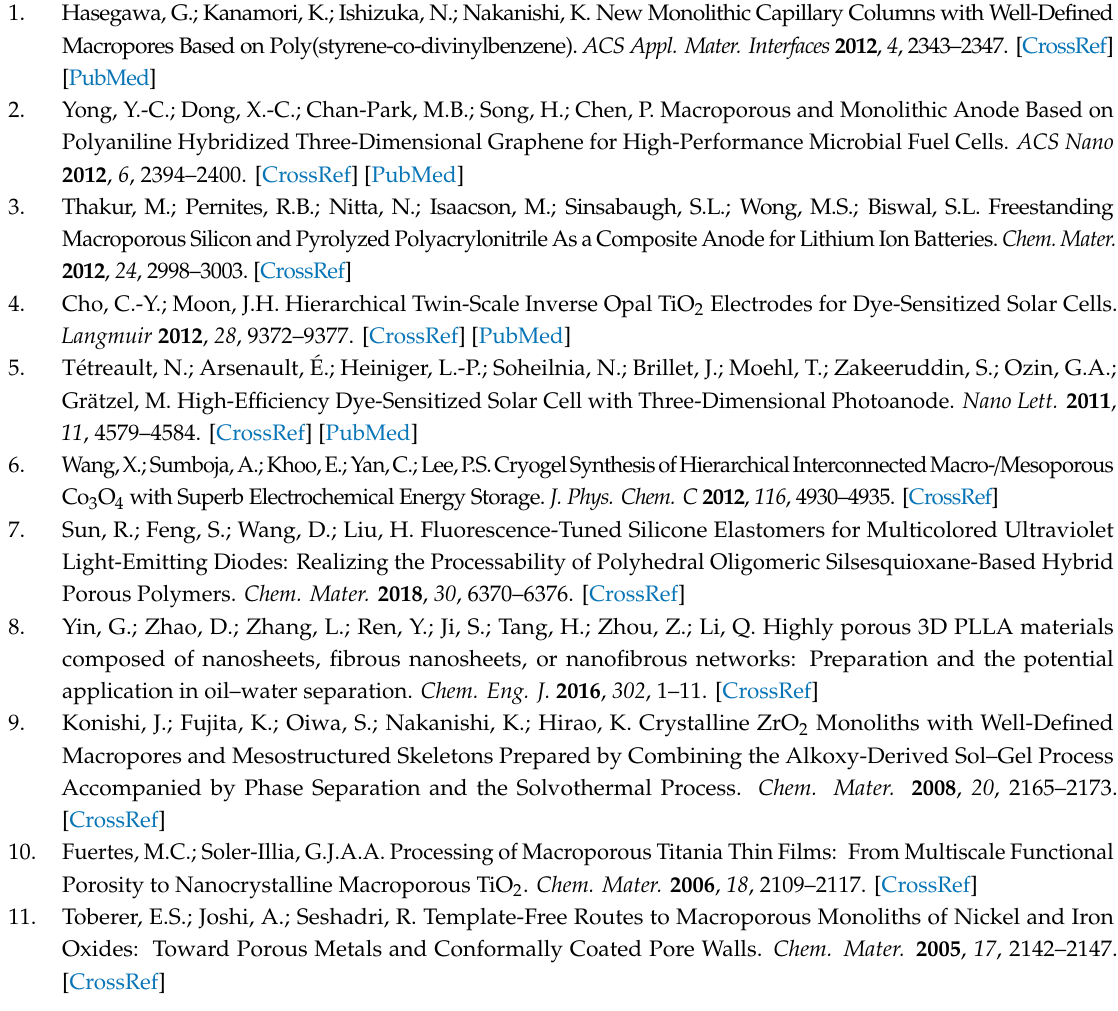
Figure S1: (a) FTIR spectrum and (b) 29 Si NMR spectrum of Octaphenylsilsesquioxanes; Figure S2: Full FTIR spectra of (a) sample A, (b) sample B and (c) sample C; Figure S3: SEM morphology of T 7 -POSS based porous materials with di ff erent reaction time (a) 5 h and (b) 20 h; Figure S4: SEM morphology of OPS based